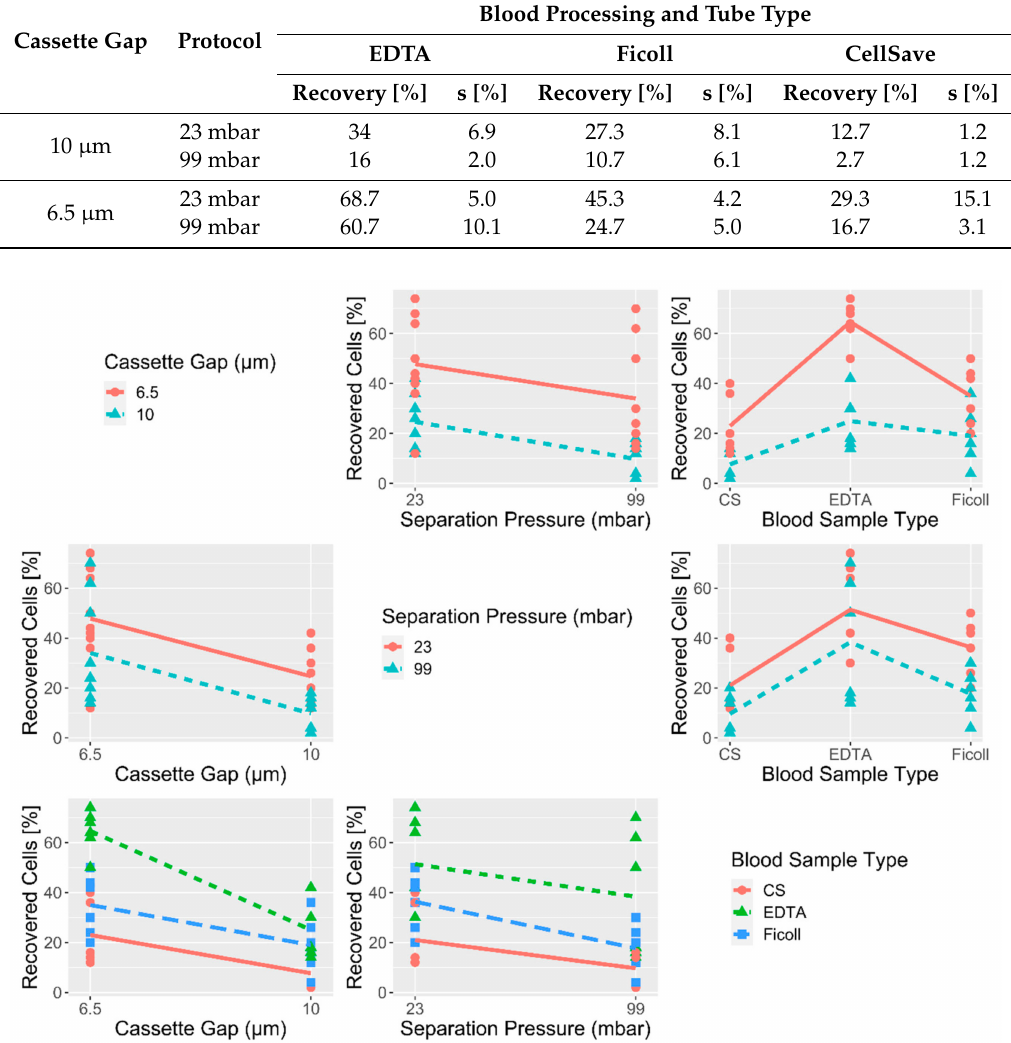
Table 1. Mean tumor cell recovery rates determined from spike experiments using MDA-MB-468 tumor cell line cells. Recovery percentages and standard deviation (s) for each cassette type, blood processing type and separation pressure are indicated.